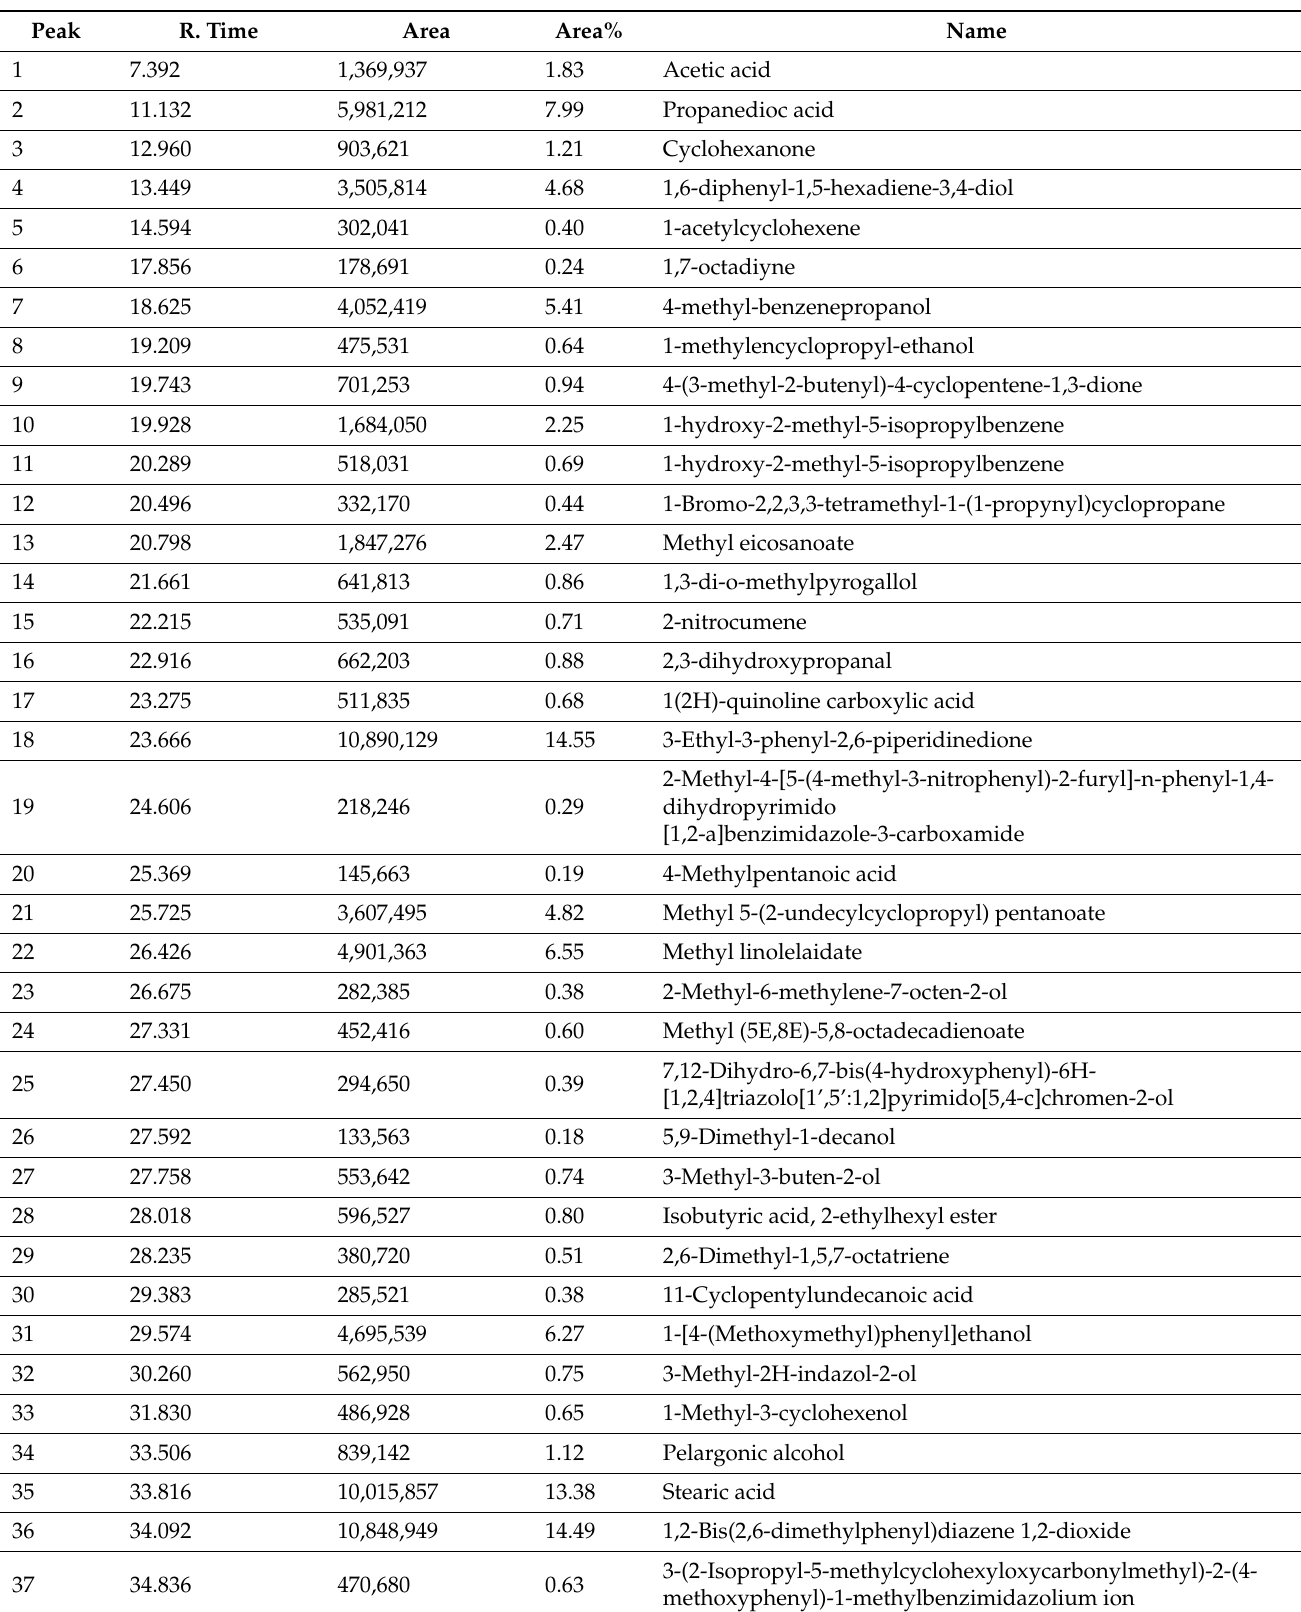
Table 1. GC–MS peak report of Carum carvi